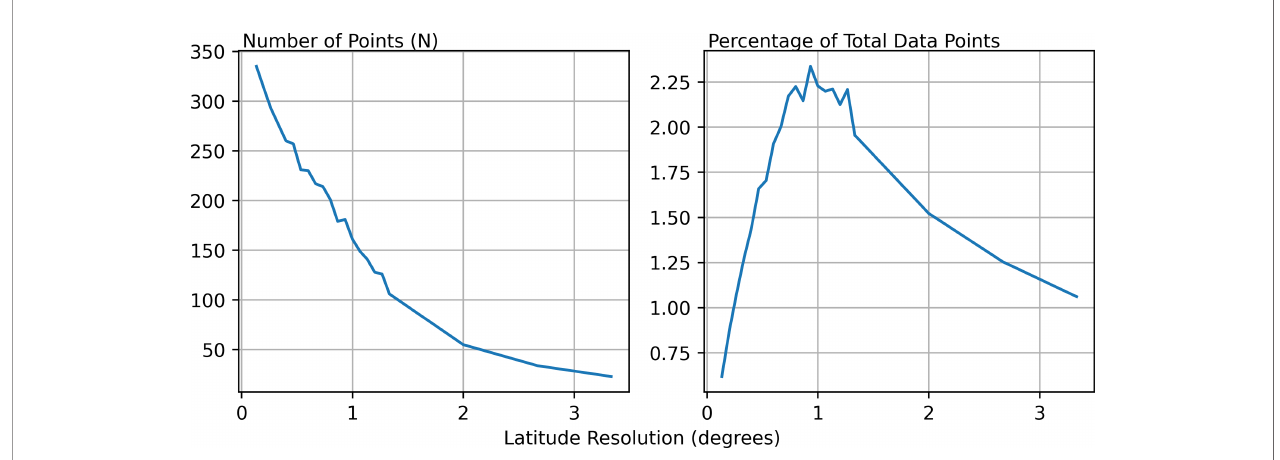
FIGURE 11 | A comparison of the number of points required to obtain a minimum correlation of 0.75 when the data has been downscaled to different resolutions. Each plot is for Sea Surface Salinity, which is used as an example. Left: The number of points required for each downscaled latitudinal resolution. Right: The number of points required as a percentage of the total number of data points within the downscaled